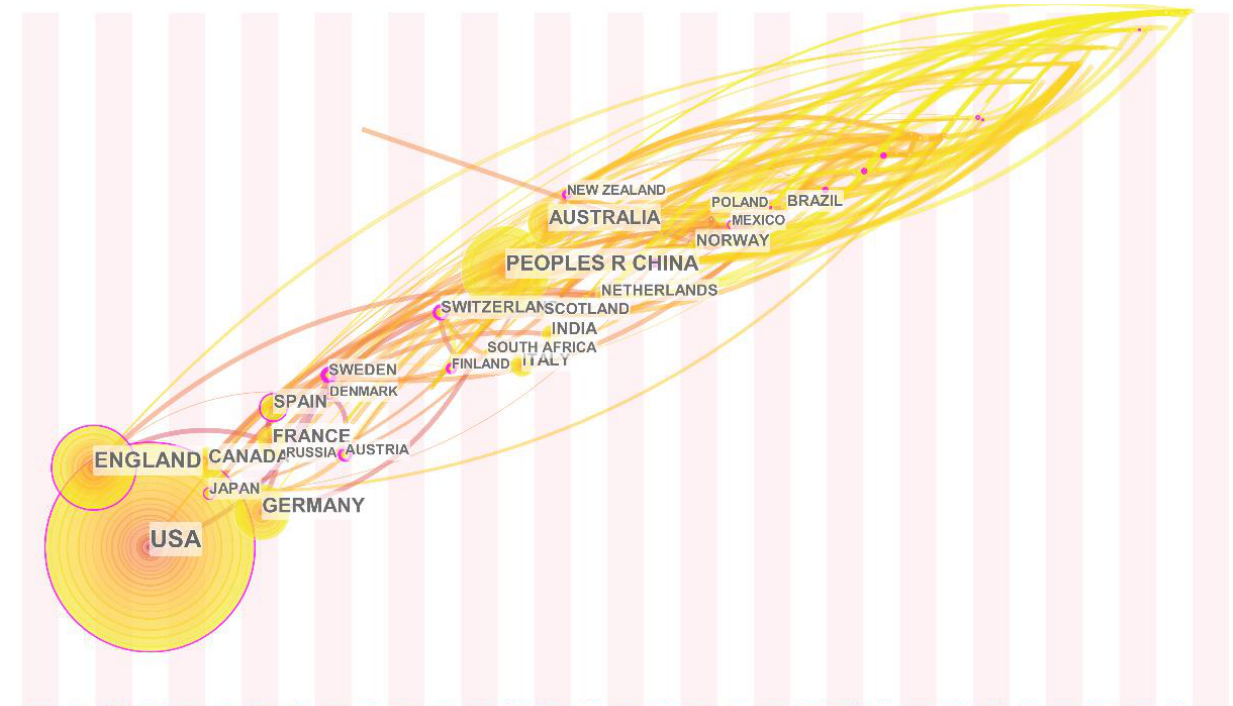
Figure 5. National time zonal mapping for RCHSCC.